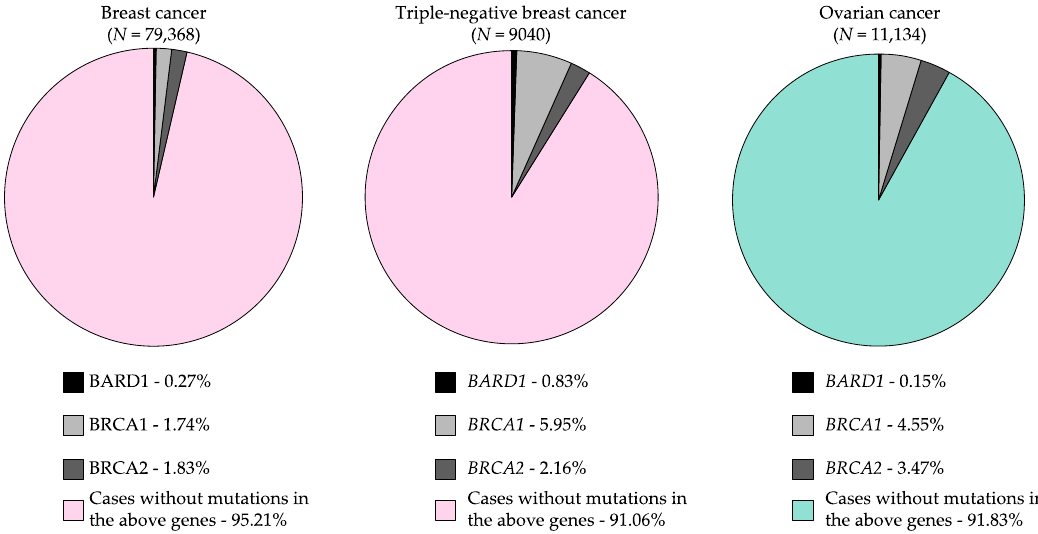
Figure 3. Proportion of carriers of pathogenic BARD1 variants in breast cancer and ovarian cancer cases relative to carriers of variants in known cancer predisposing genes, BRCA1 and BRCA2 . a Source: Interactive Prevalence Tables From Multi-Gene Panel Testing: A collaboration between investigators from Mayo Clinic and Ambry Genetics ® [143] (www.ambrygen.com / clinician / resources / prevalence-tool). Table 4. Prevalence of BARD1 variants in breast and ovarian cancer cases a .